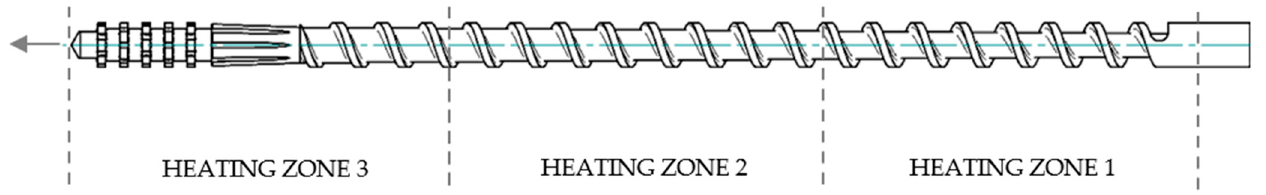
Figure 1. Screw configuration of the single-screw extruder.